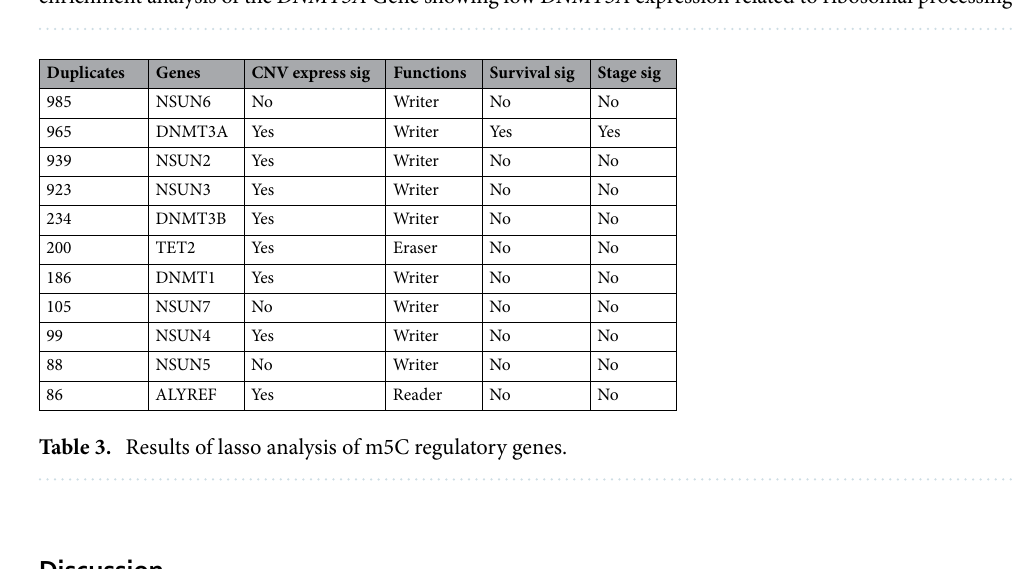
Figure 5. Relationship between m5C regulatory gene expression and patient prognosis, with DNMT3A gene functional enrichment analysis. The impact of 13 m5C regulatory genes on patient prognosis using multivariate Cox regression. ( A , B ) Multivariate Cox regression of survival ( P < 0.001) and AUC curves (AUC curve areas > 0.65). ( C ) Relationship between DNMT3A expression and patient prognosis ( P = 0.036). ( D – F ) GSEA enrichment analysis of the DNMT3A Gene showing low DNMT3A expression related to ribosomal processing.